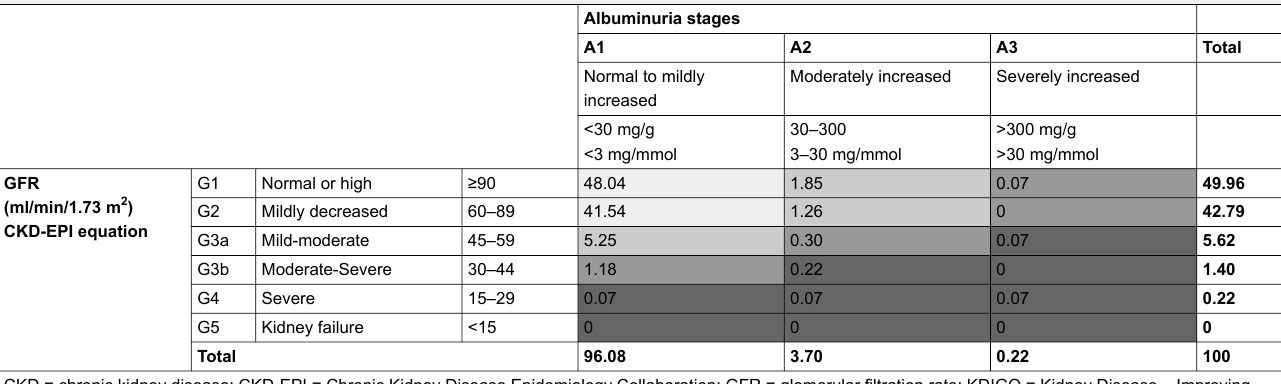
Table 2: Distribution of the chronic kidney disease risk categories according to KDIGO (2012).